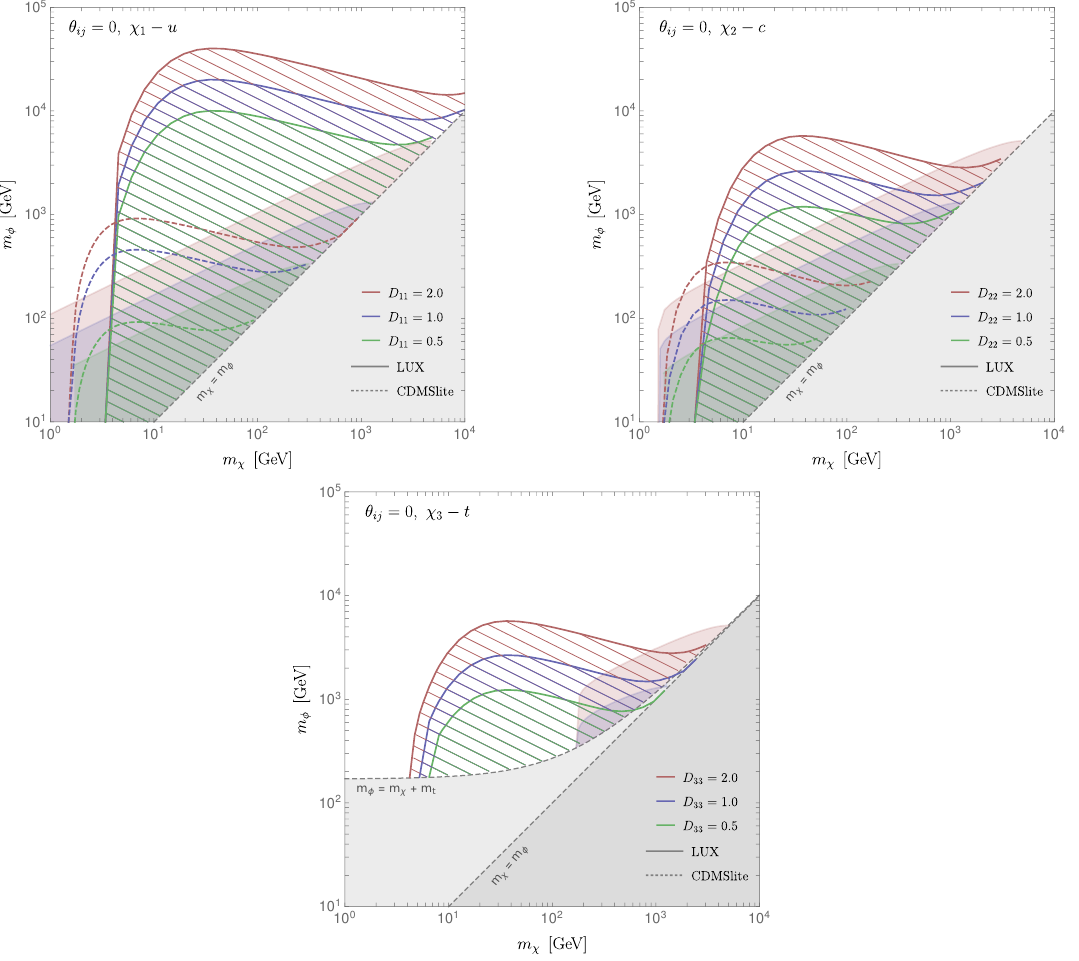
exclusively coupling to u quarks, (cid:31) 1 2